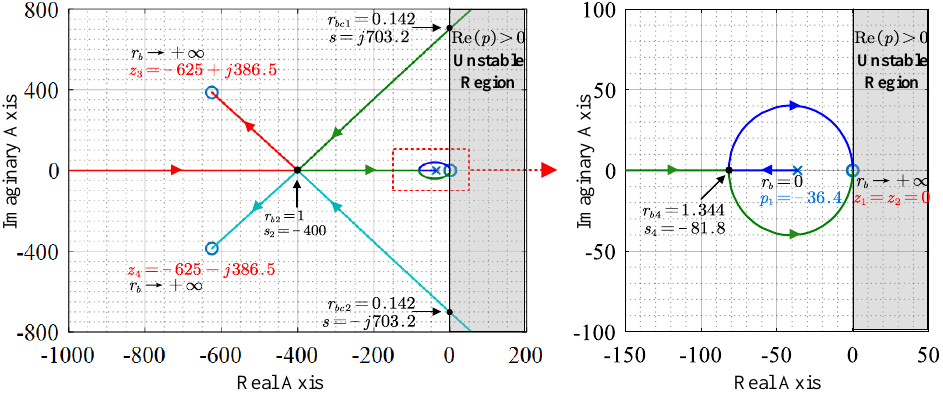
Figure 4. Root locus plot with respect to r b .